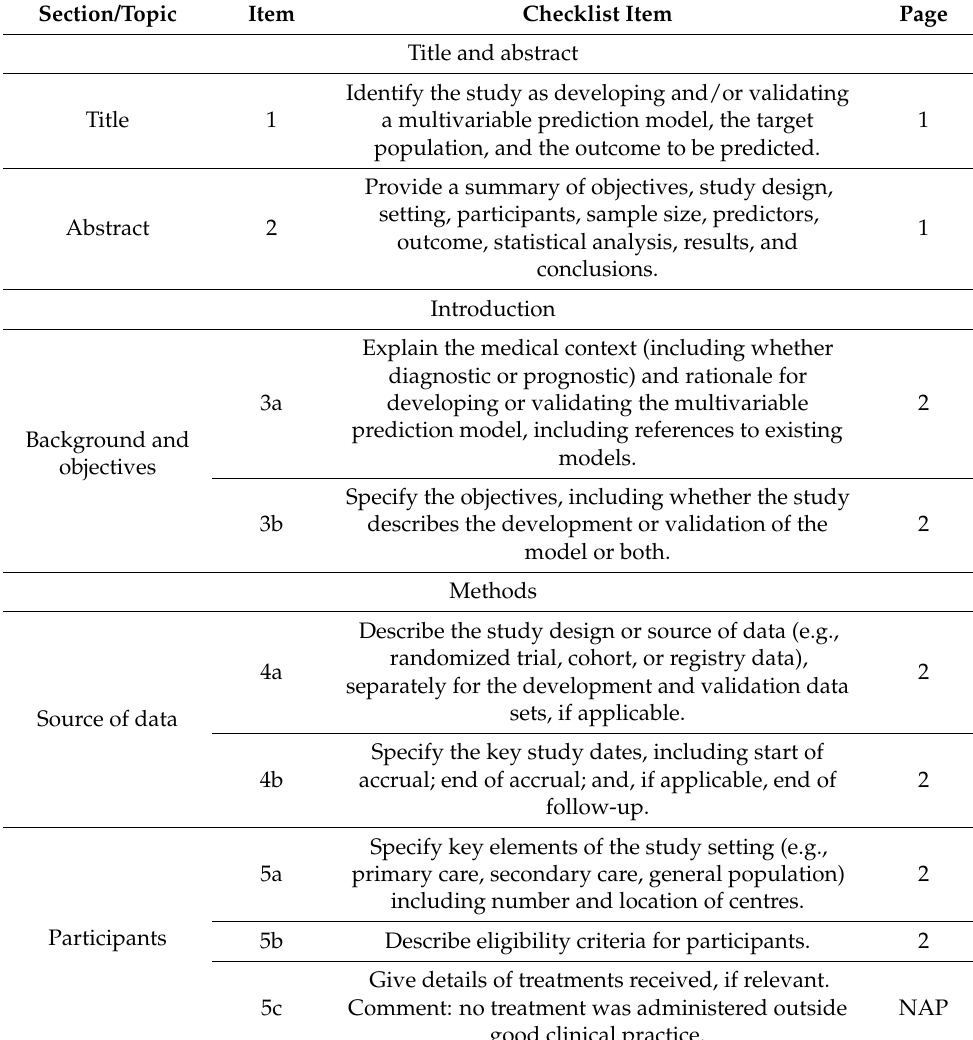
Table A1. TRIPOD (Transparent reporting of a multivariable prediction model for individual prog- nosis or diagnosis) checklist